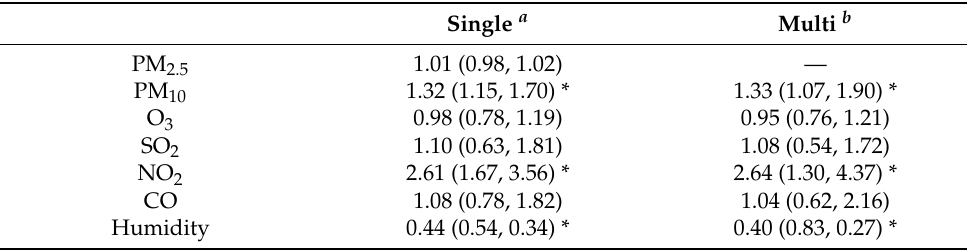
Table 3. Adjusted ORs (95% CI) for DED associated with an IQR increase of air pollutants and humidity.